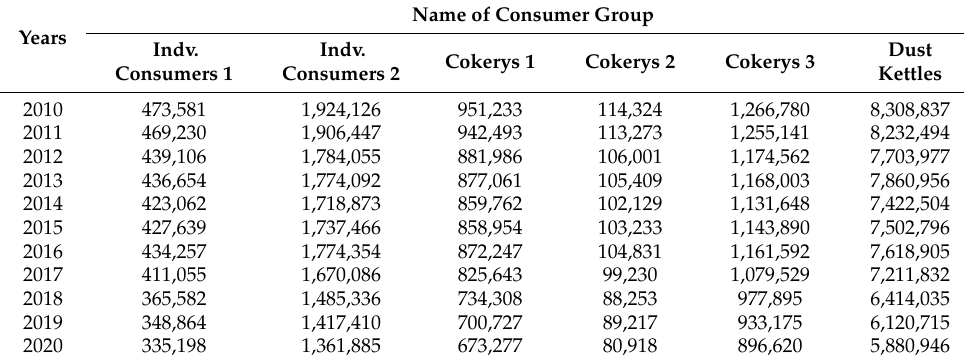
Table A2. The historical volumes of coal demand from the domestic consumers in the years 2010–2020, (Mg).